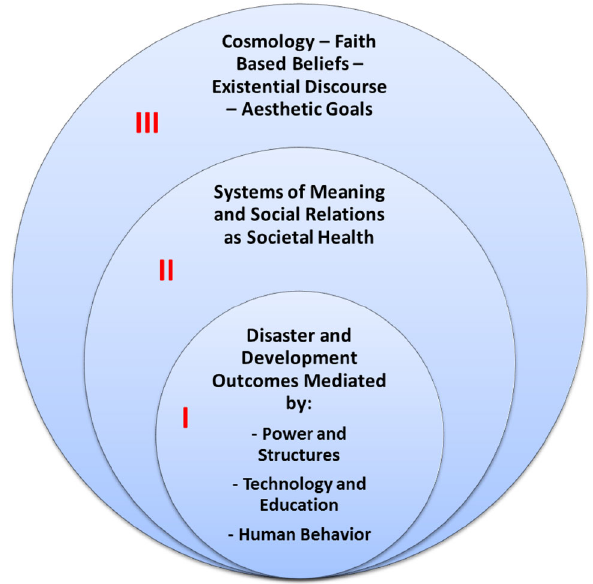
Fig. 1 Multileveled view of disaster and